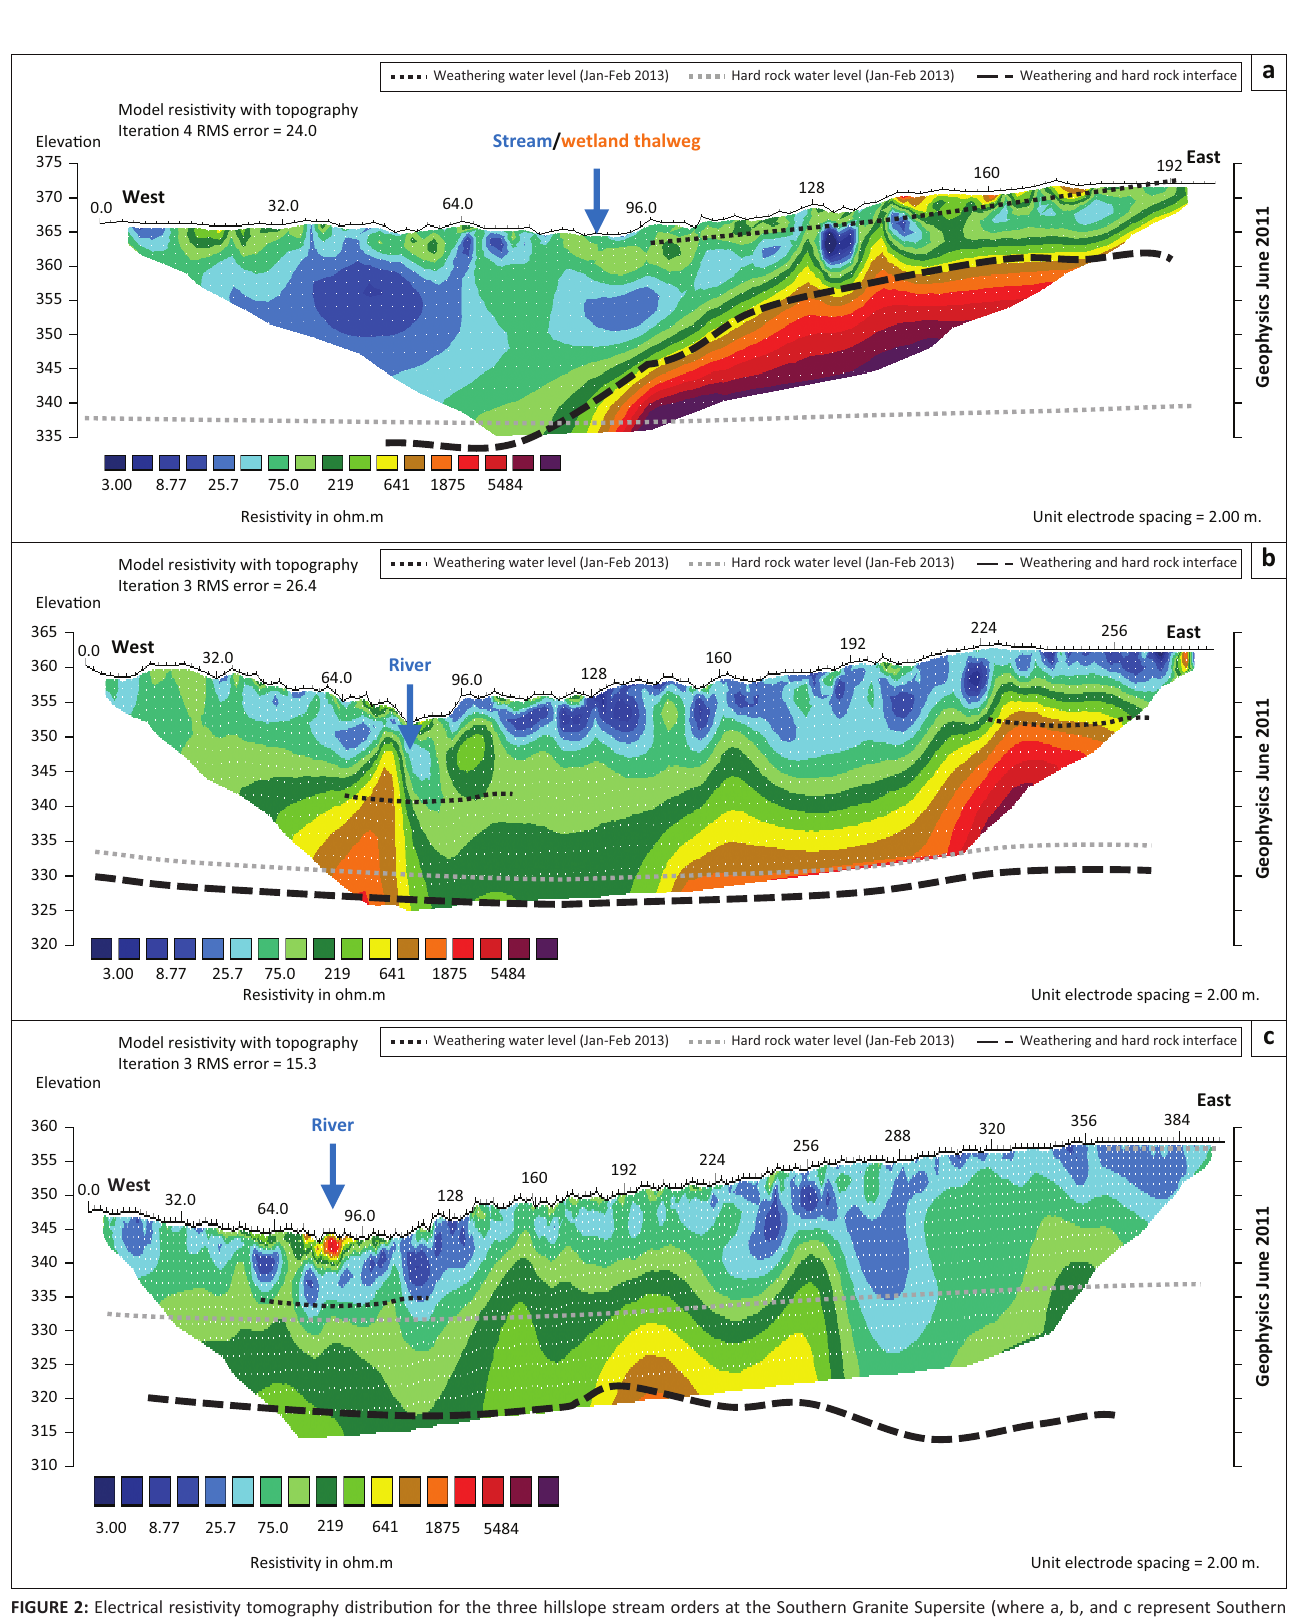
FIGURE 2: Electrical resistivity tomography distribution for the three hillslope stream orders at the Southern Granite Supersite (where a, b, and c represent Southern Granite Supersite 1, Southern Granite Supersite 2 and Southern Granite Supersite 3,